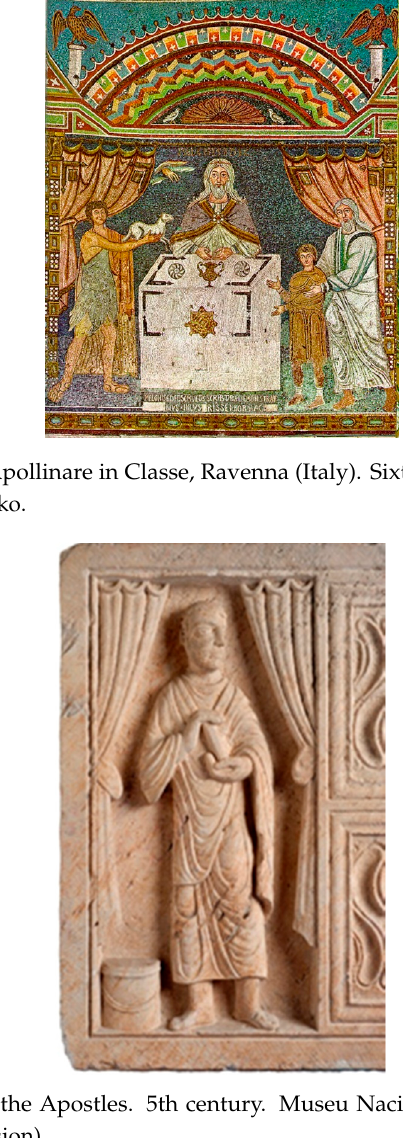
Figure 20. Sarcophagus of the Apostles. 5th century. Museu Nacional Arqueològic de Tarragona ©MNAT (with kind permission).